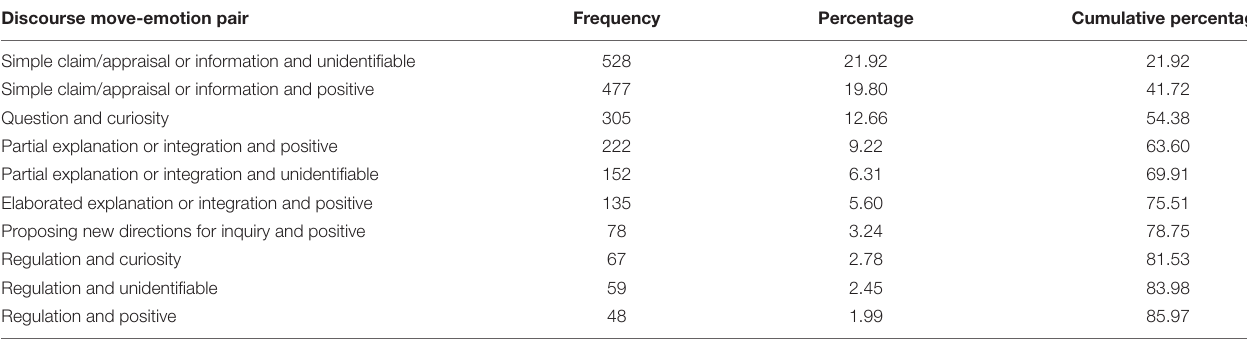
TABLE 5 | The descriptive data of the 10 most occurring discourse move-emotion states in metadiscourse sessions. Discourse move-emotion